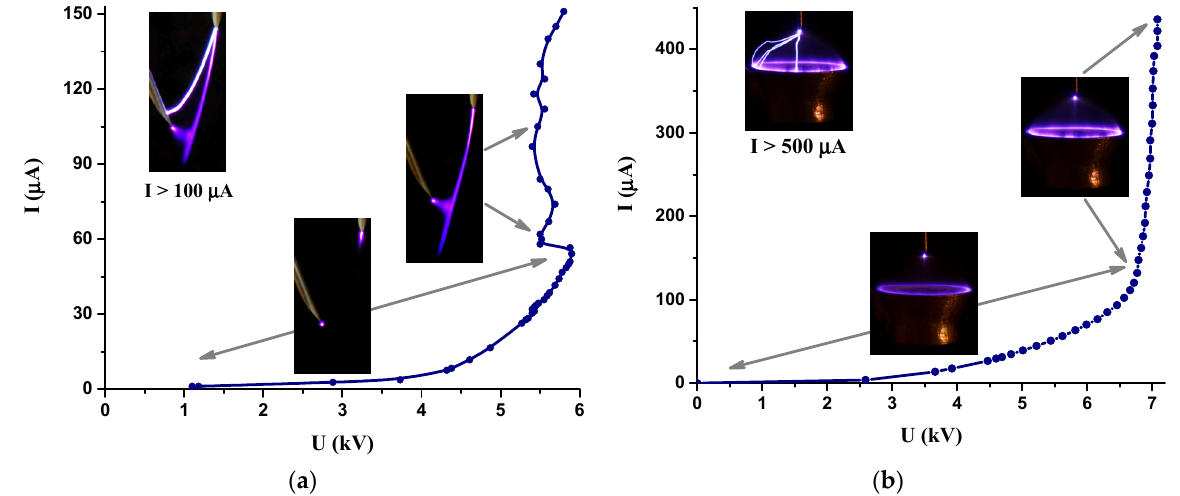
Figure 2. The volt–ampere characteristics and relevant images of the cometary discharge ( a ) and the point-to-ring discharge ( b ).